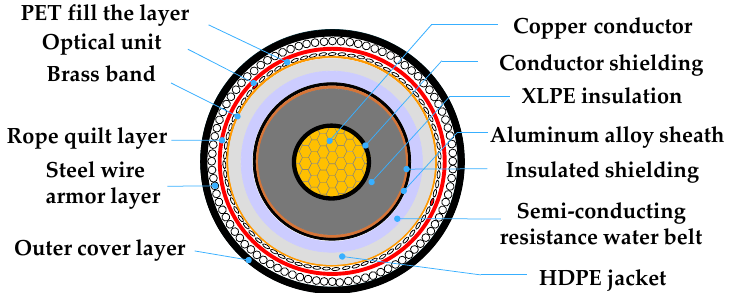
Figure 3. Single core submarine cable structure diagram. Model YJQ41 12-layer single-core fiber-optic composite submarine cable structure planing surface, a 12-layer structure.